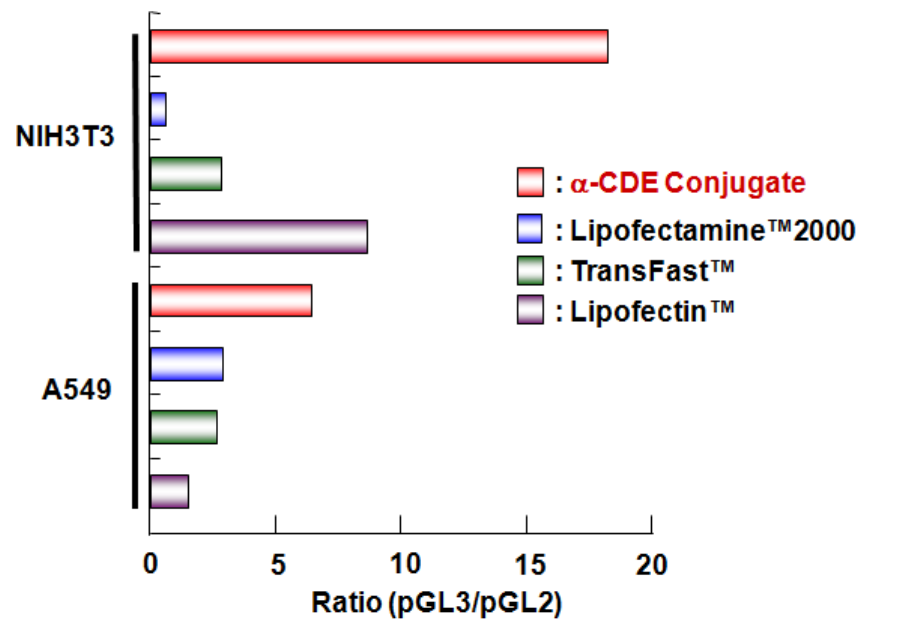
Figure 2. Comparison of inhibitory effects of vectors in various cells transfected with ternary complexes of pDNA/siRNA/ α -CDE (G3, DS